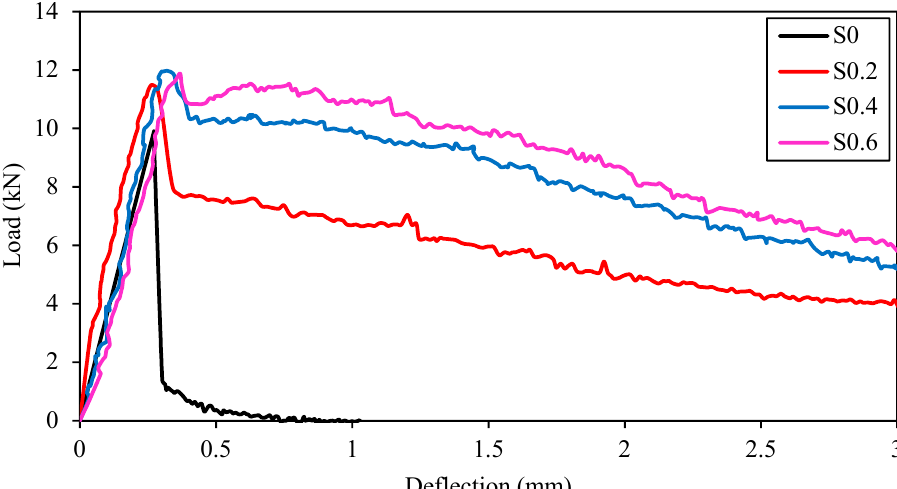
Figure 7. Load-deflection curves of alkali-activated mixtures containing various RTSF fractions subjected to four-point bending tests.